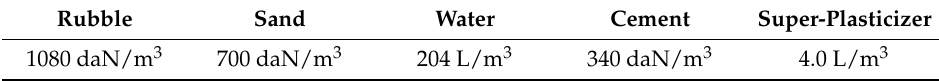
Table 4. Composition of ordinary concrete (ORD) mix per unit of volume.